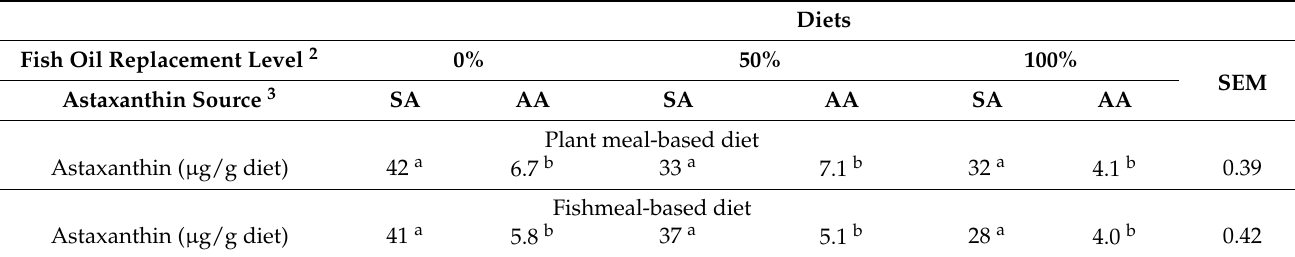
Table 1. Analyzed concentrations of astaxanthin in experimental diets 1